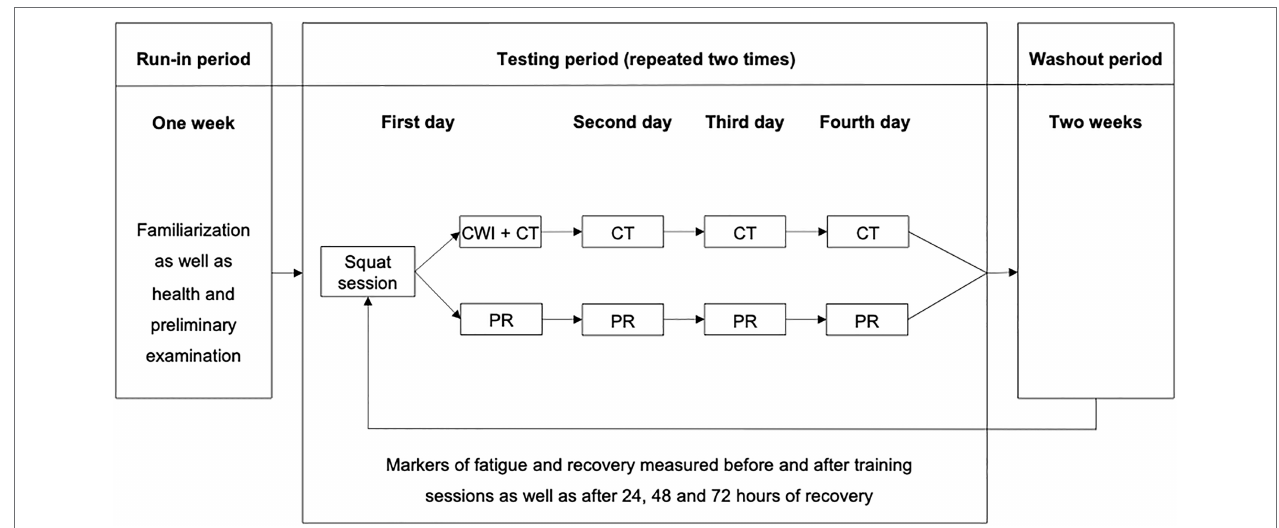
FIGURE 1 | Experimental design. CWI, cold water immersion; CT, compression tights; and PR, passive